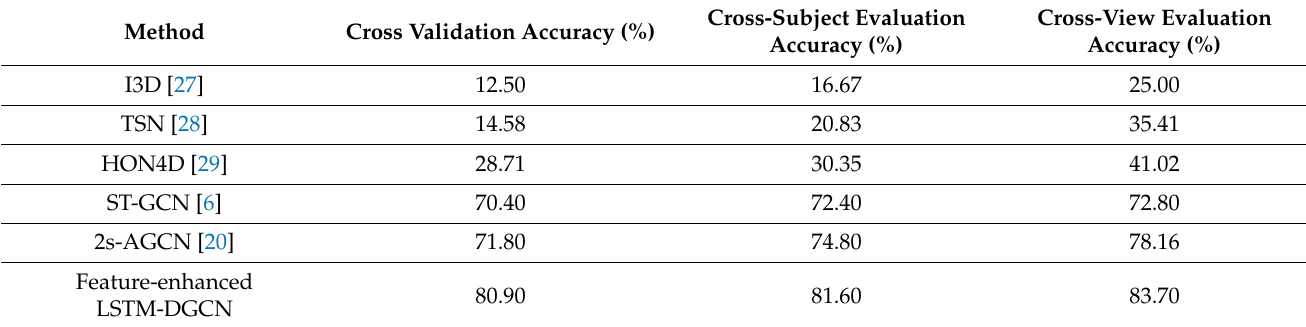
Table 4. The results of the three evaluation settings of our benchmark using different methods. Method Cross Validation Accuracy